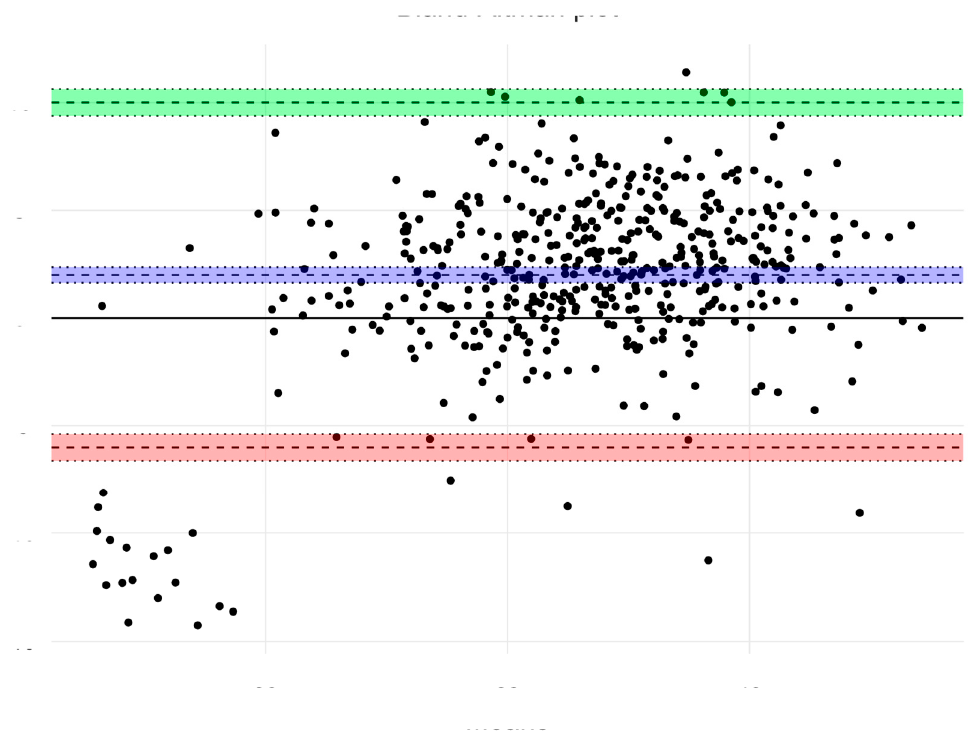
Figure 3. Bland–Altman Plot of agreement between muscle mass estimation using bioimpedance analysis (BIA) and Matiegka method. The overall agreement is average, with a mean bias value